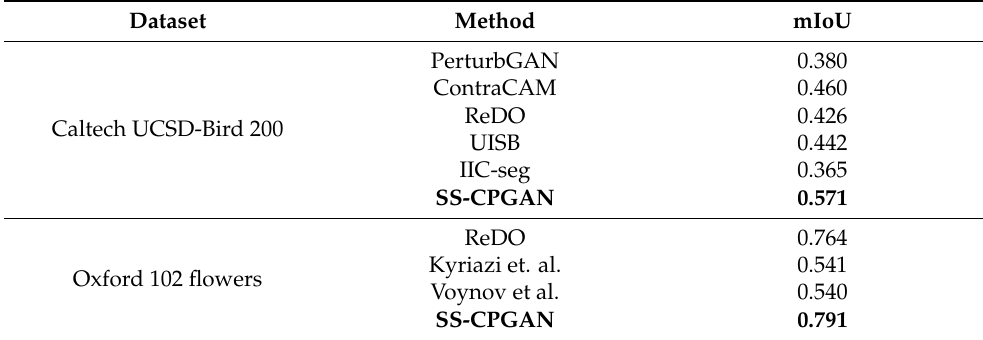
Table 5. Quantitative comparison of the segmentation performance of our method SS-CPGAN with the